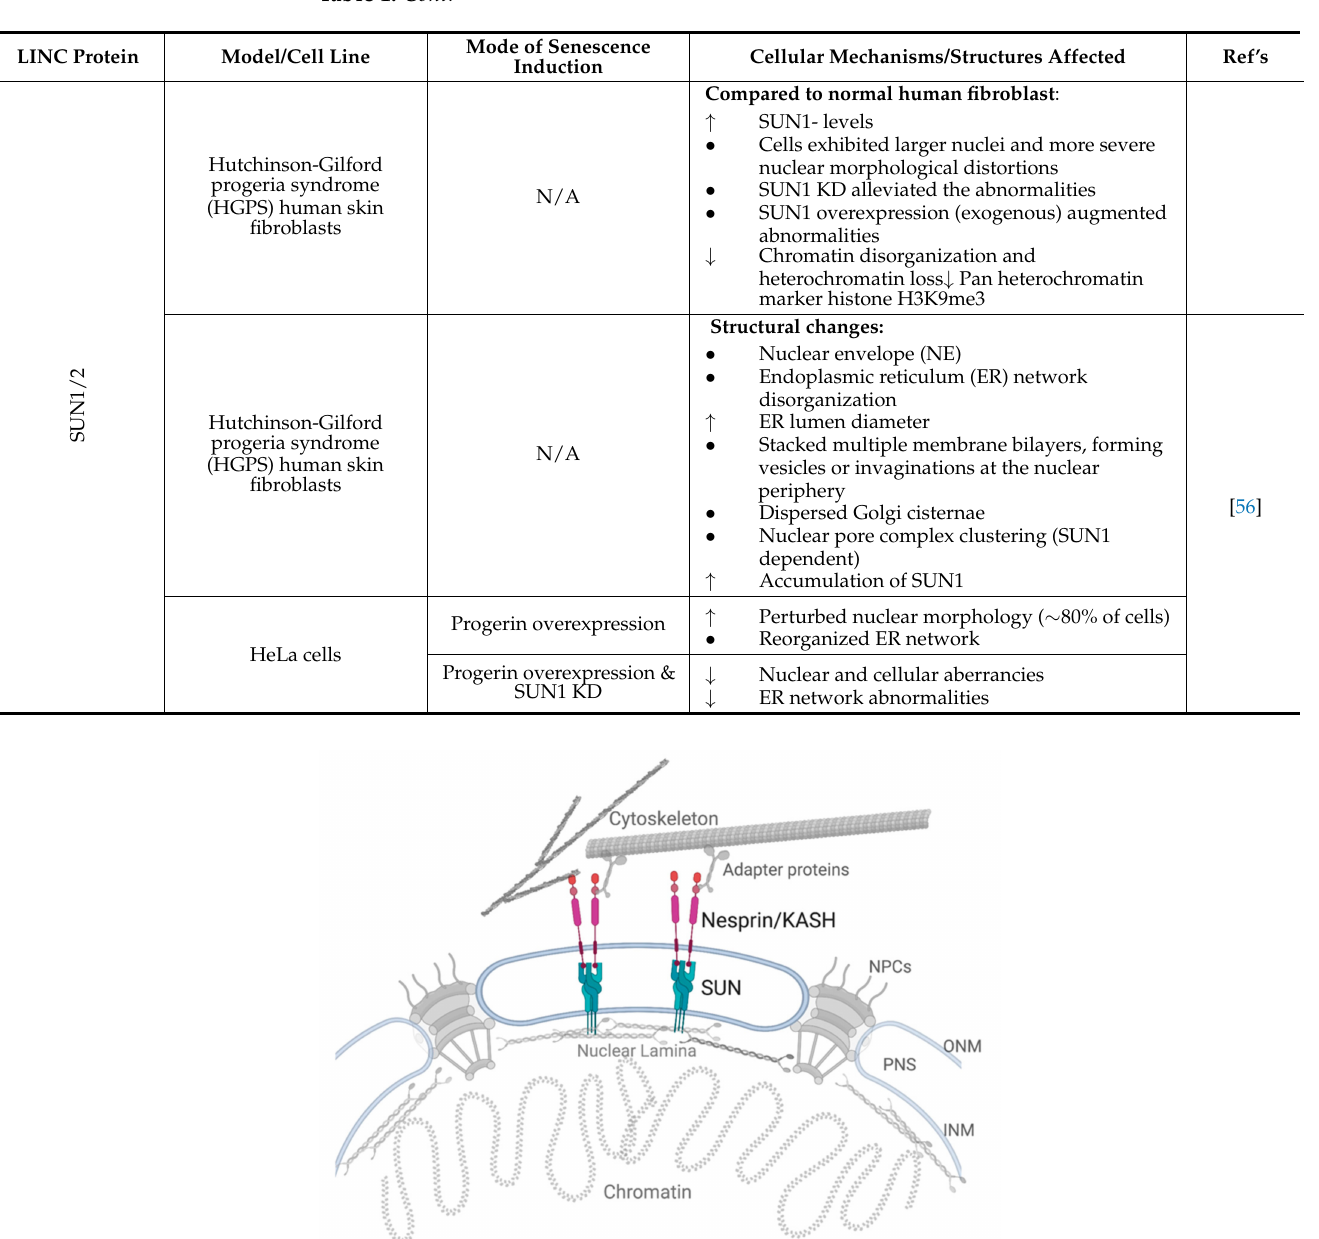
Figure 1. The LINC complex spans the nuclear membrane and connects the cytoskeleton to the nucleoskeleton. The nuclear membrane is composed of an outer nuclear membrane (ONM) and inner nuclear membrane (INM), which are separated by a perinuclear space (PNS). The ONM and INM are connect at sites of nuclear pore complex (NPC) insertion. SUN-domain proteins reside in the INM and connect to ONM KASH-domain proteins in the PNS, forming the core of the LINC complex. KASH domain proteins connect to the cytoskeleton either by direct interaction (actin) or through adapter proteins (microtubules (shown) and intermediate filaments (not shown)). Created with BioRender.com (accessed on 20 May